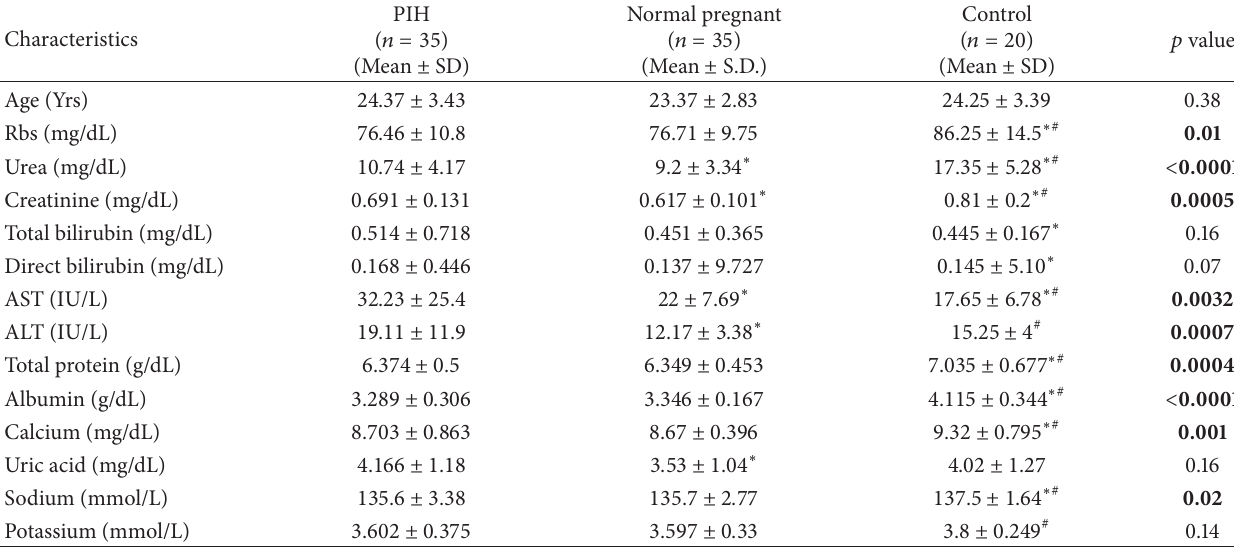
Table 1: Biochemical variables of PIH, normal pregnant, and control subjects.